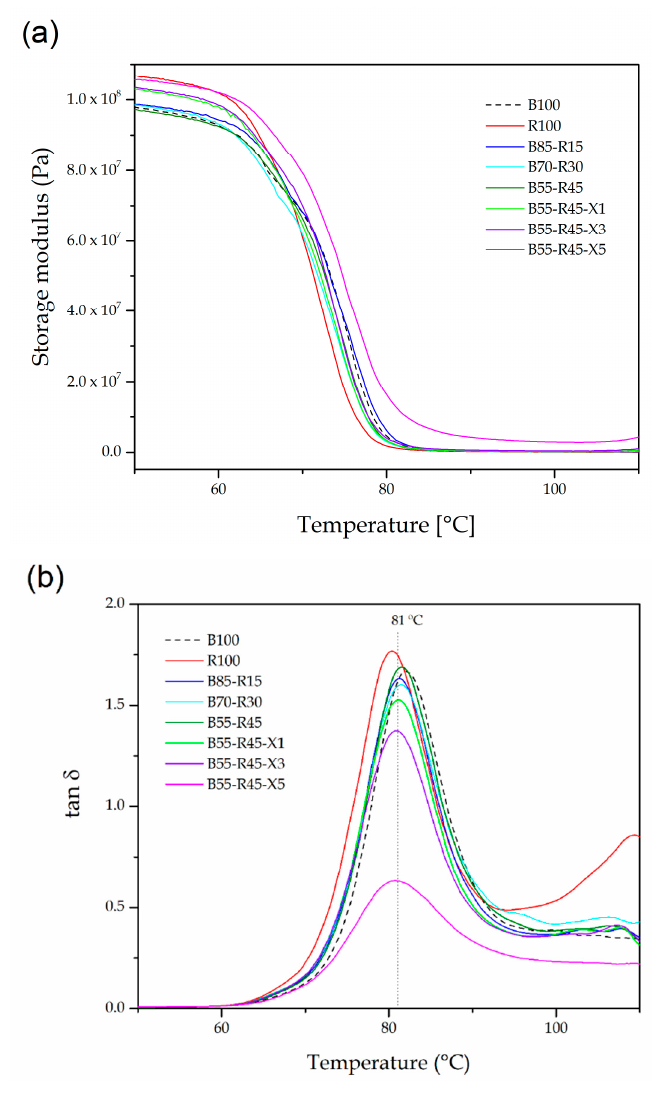
Figure 6. ( a ) Storage modulus and ( b ) damping factor ( tan δ ) of the injection-molded pieces of the